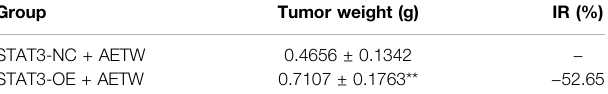
TABLE 5 | Mice body weight of the two experiment groups (STAT3-NC + AETW, STAT3-OE + AETW). Group